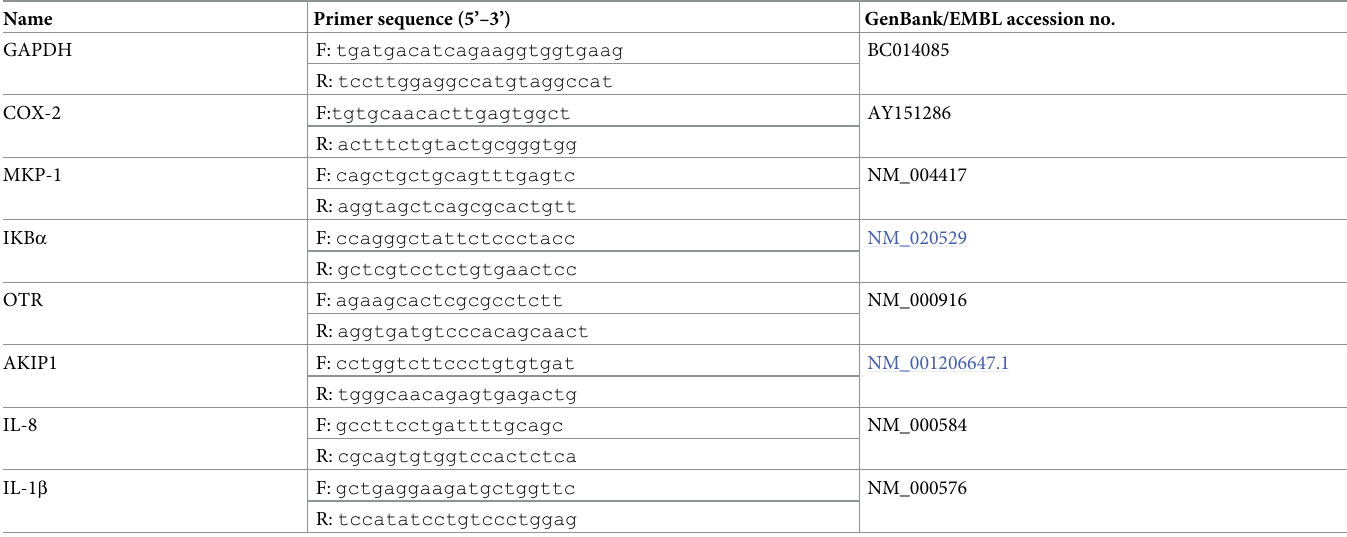
Table 4. Primer pair sequences with gene accession